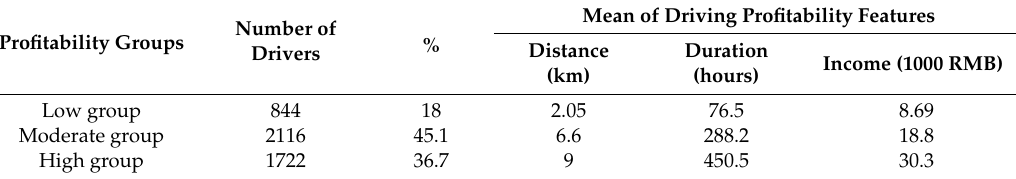
Figure 4. Occupancy ratio of high, moderate and low profitability drivers.